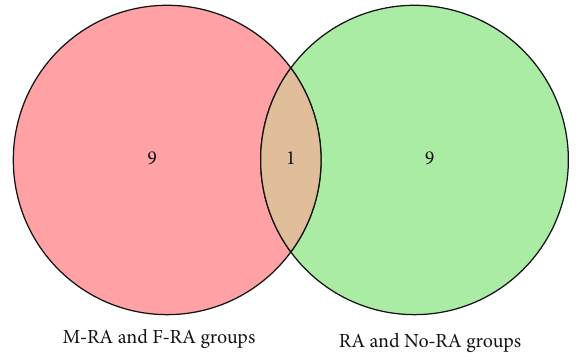
Figure 6: Intersection of 2 sets of top 10 hub